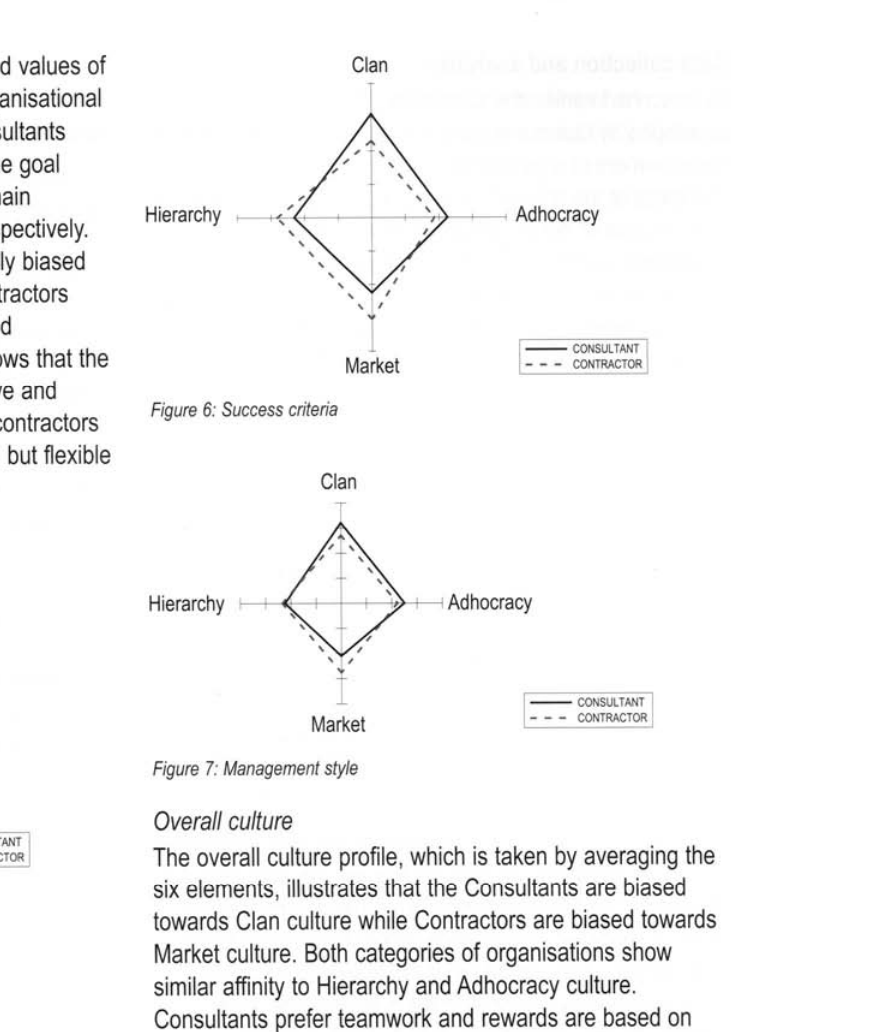
Figure 4: Organisational glue